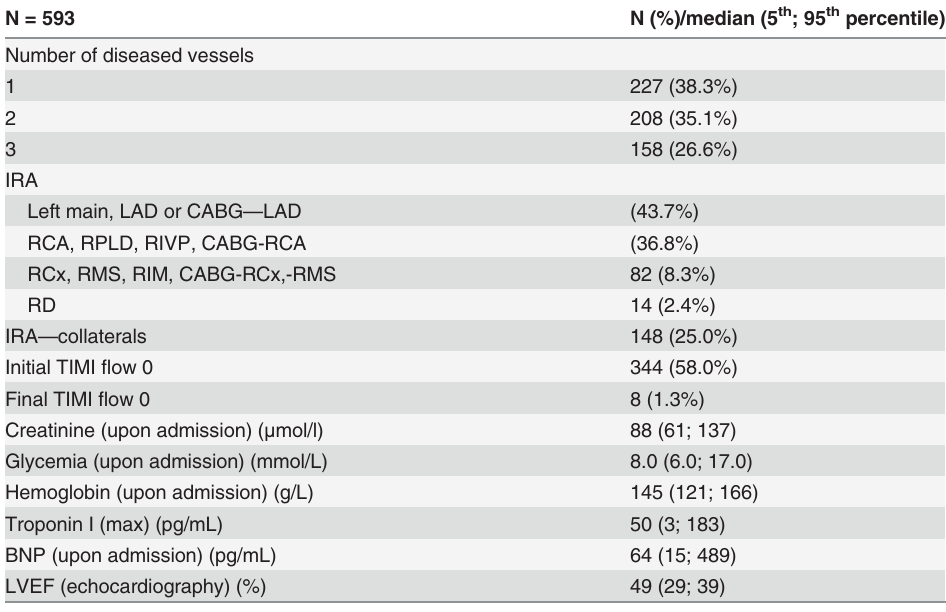
Table 3. Characteristics of laboratory tests and invasive